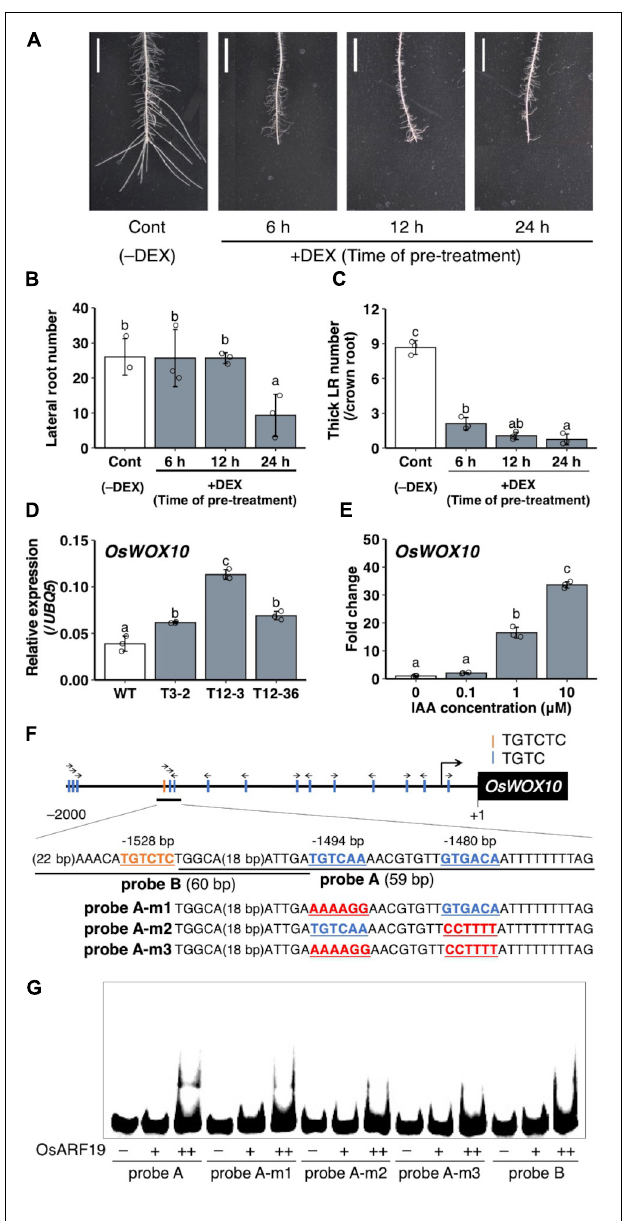
FIGURE 7 | Analysis of the involvement of auxin signaling for lateral root (LR) diameter control and OsWOX10 expression. (A–C) Root tip excision in pOsAct1 -m OsIAA3 - GR transgenic plants in the background of Nipponbare with or without the m OsIAA3 activation by dexamethasone (DEX). DEX was pre-treated before root tip excision for different durations. (A) LR formation on crown roots (CRs) 3 days after root tip excision. Scale bars = 1 cm. (B) Total LR number in 0–1 cm from the cut site. (C) Number of thicker LRs ( ≥ 150 µ m) per CR in (A) ( n = 3 biological replicates). (D) OsWOX10 expression levels in seminal roots with developing LRP in wild-type (WT) and the mutants. (E) OsWOX10 expression levels after 1 h of IAA treatment with graded concentrations ( n = 3 biological replicates). Values represent mean ± SD. Different letters indicate significant differences among groups ( P < 0.05). (F) Schematic diagram showing auxin-response elements located in 2 kb upstream of OsWOX10 and probe sequences used in (G) . (G) Electrophoresis mobility shift assay (EMSA) in recombinant OsARF19 DNA-binding domain with Cy5-labeled probes containing candidate sequences in OsWOX10